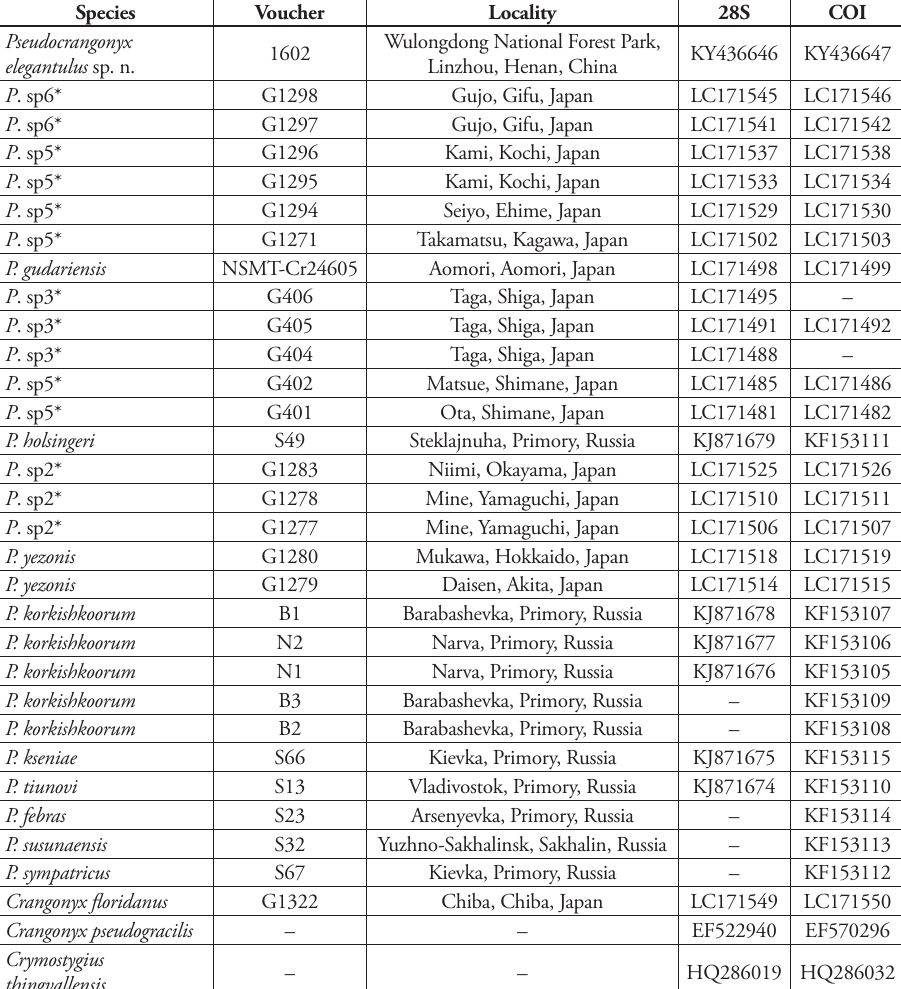
Table 1. Samples used for the phylogenetic analyses. The locality information is accompanied by sequence accession numbers. Species names marked with an asterisk were obtained from Tomikawa et al. (2016). Species Voucher Locality 28S COI Pseudocrangonyx elegantulus sp.